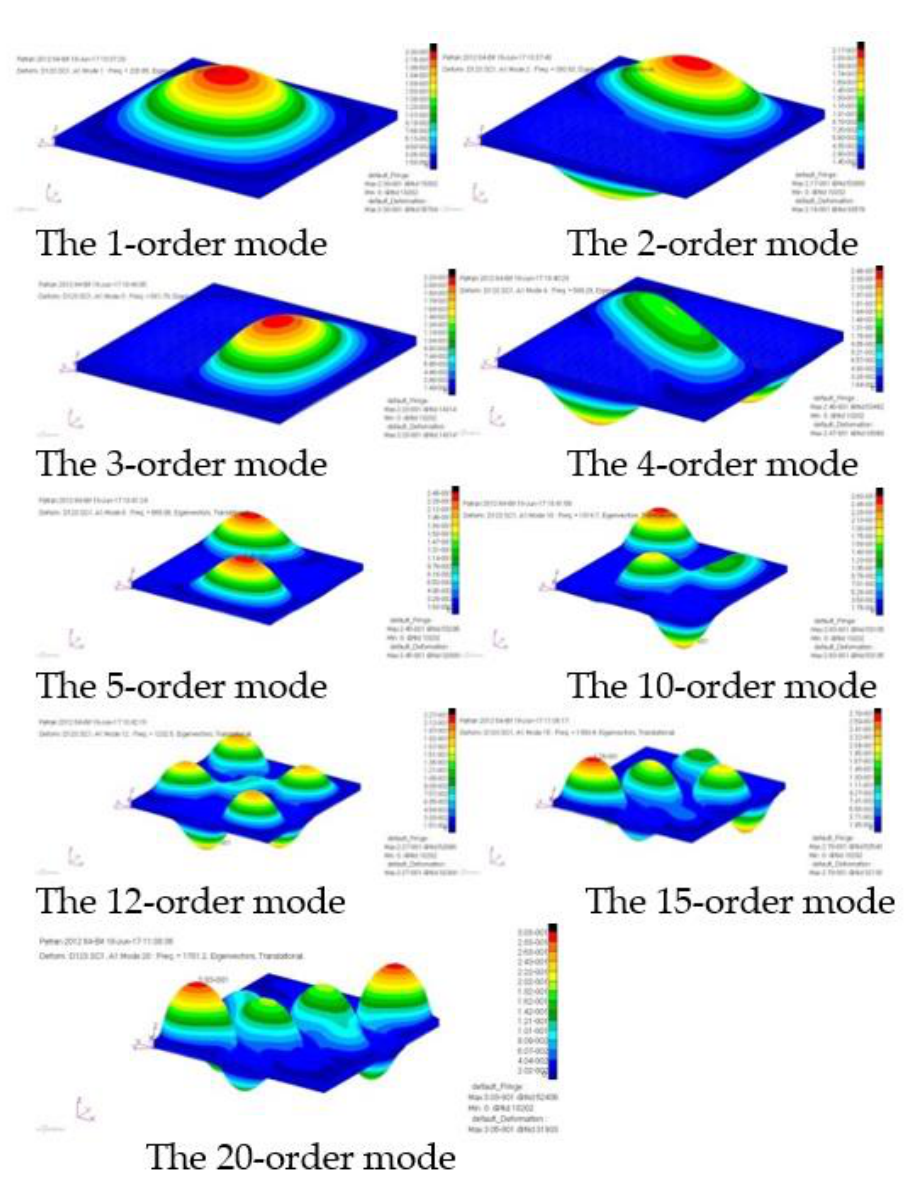
Figure 3. The typical modes of the composite plate. Results of the Composite Plate The modes of the composite plate are shown in Figure